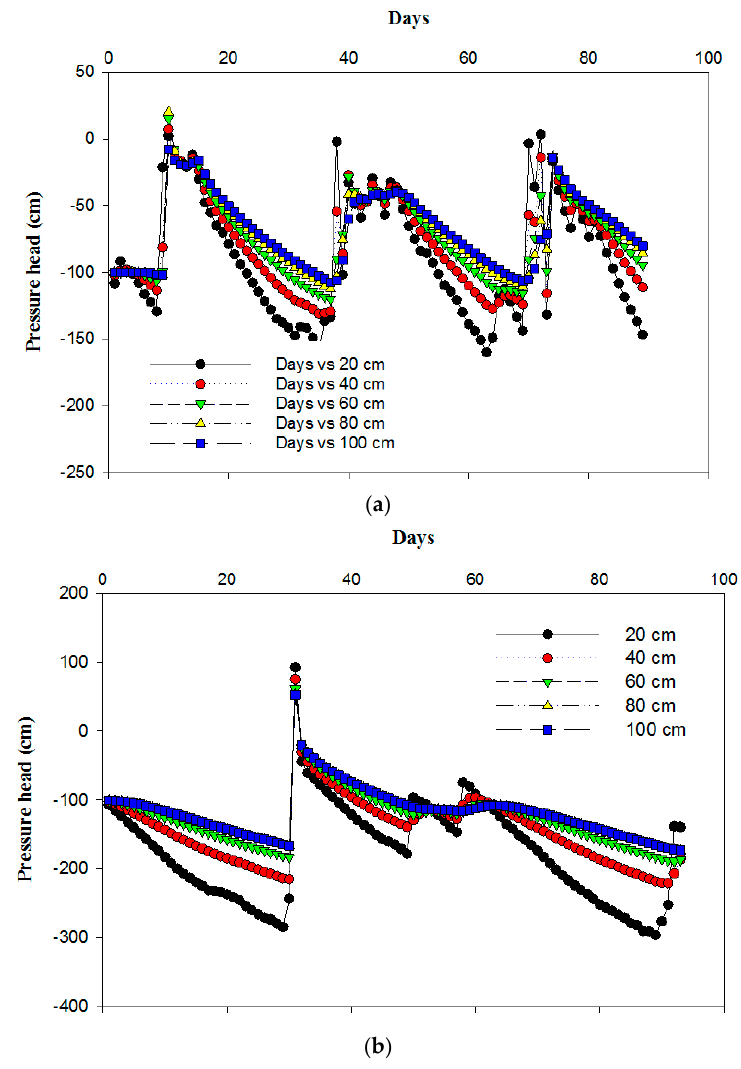
Figure 2. Simulated pressure heads at different soil depths 20, 40, 60, 80, and 100 cm during the ( a ) off-season ( b ) main season.